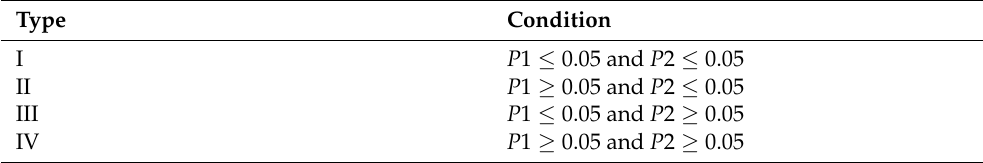
Table 1. Conditions for the classification of alarm